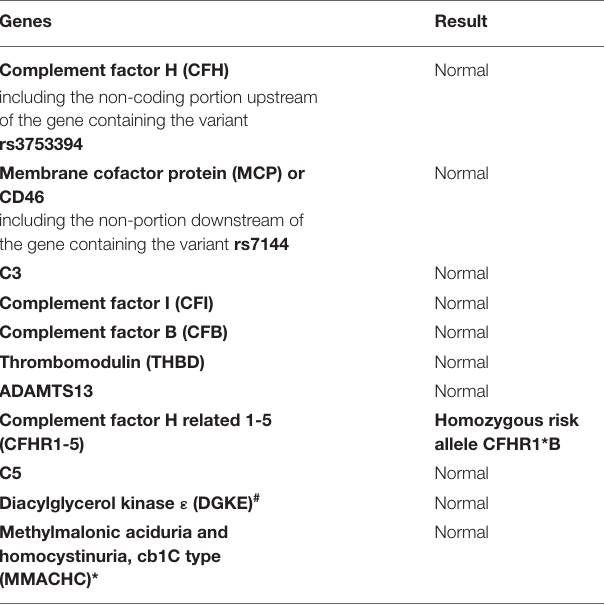
TABLE 3 | Complement system: sequencing analysis by Next-Generation Sequencing (NGS).